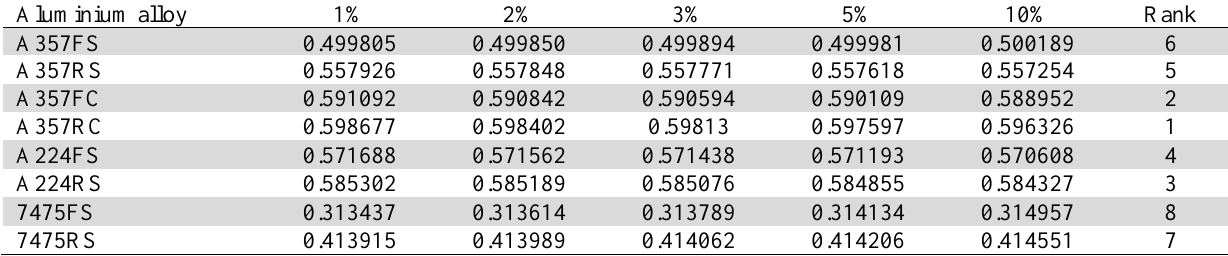
Effect of change in greyness on ranking of aluminium alloys Aluminium